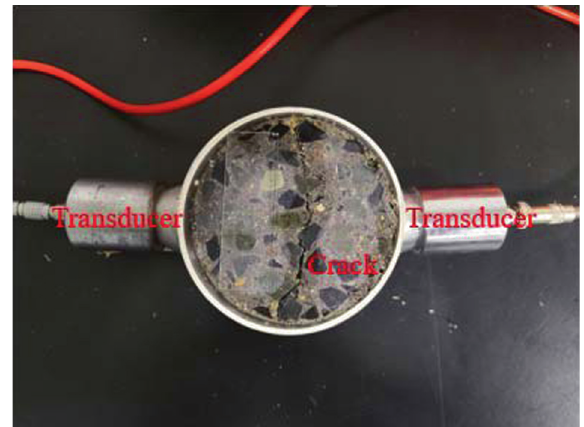
Figure 8: Diagram of the ultrasonic